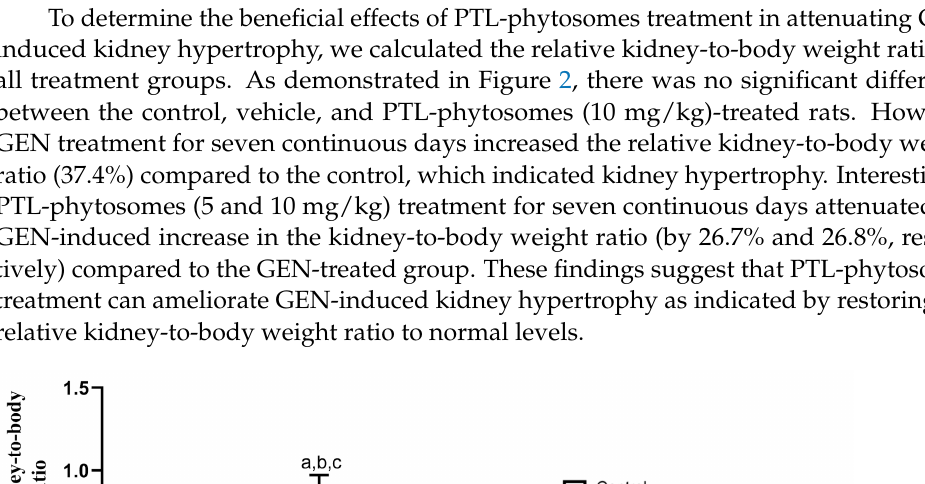
Figure 2 . PTL-phytosomes treatment improved the relative kidney-to-body weight ratio. Data are expressed as Mean ± SD ( n = 6). a: significant when compared to control at p < 0.05; b: significant when compared to vehicle at p < 0.05; c: significant when compared to PTL-phytosomes at p < 0.05; d: significant when compared to (GEN)- alone at p < 0.05.